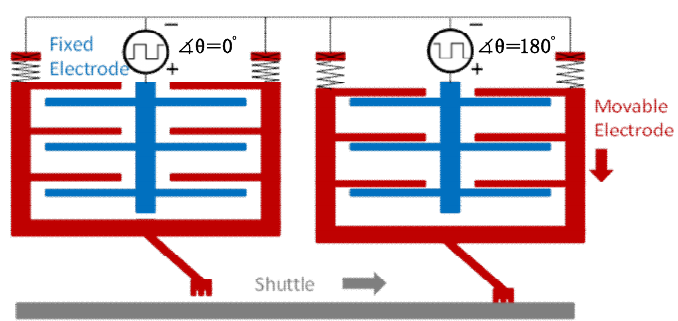
Figure 10. Electrostatic inchworm motor.